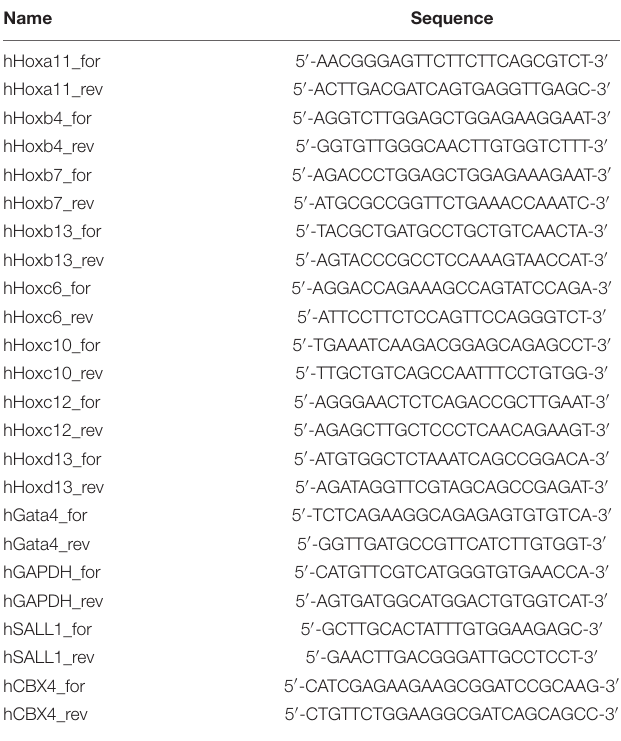
TABLE 2 | Oligonucleotide sequences used for